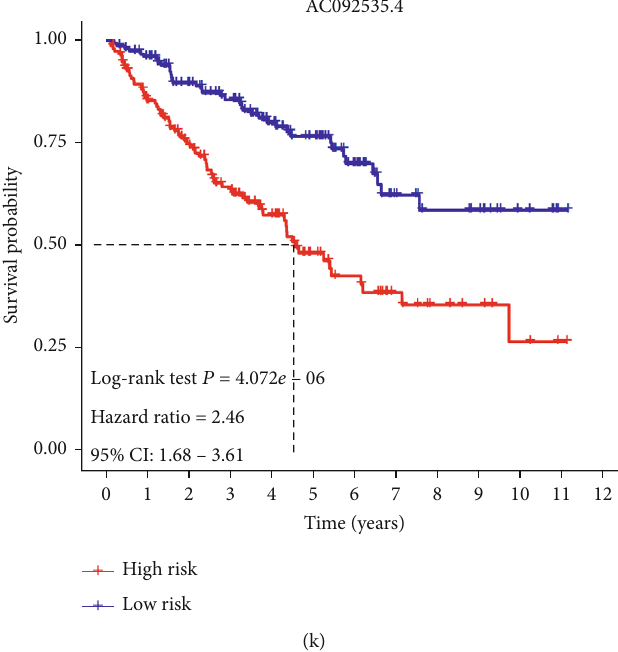
Figure 3: Expression pattern and Kaplan-Meier survival analysis of the fi ve PIDElncRNAs. (a) Expression pattern of the fi ve PIDElncRNAs between 72 normal samples and 512 tumor samples. (b – f) Paired expression pattern of the fi ve PIDElncRNAs between 72 normal samples and 72 tumor samples. (g – k) Survival analysis of the fi ve PIDElncRNAs. PIDElncRNAs: prognostic immune-related di ff erentially expressed lncRNAs; ∗ P < 0 : 05 , ∗∗ P < 0 : 01 , and ∗∗∗ P < 0 : 001